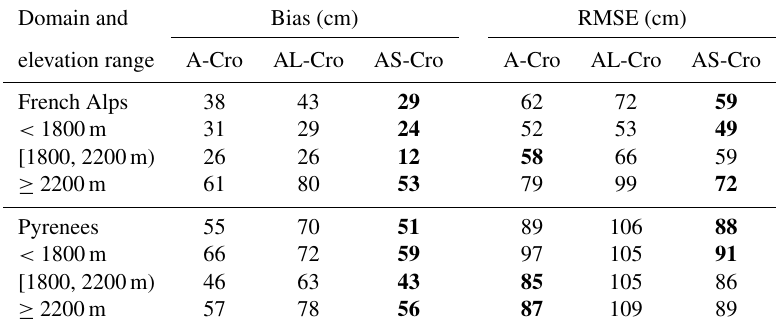
Table 4. Bias and root mean square error (RMSE) of snow depth at 172 stations of the French Alps and the Pyrenees over the period 2010– 2014 for simulations A-Cro, AL-Cro and AS-Cro. The best metrics are given in bold. Domain and